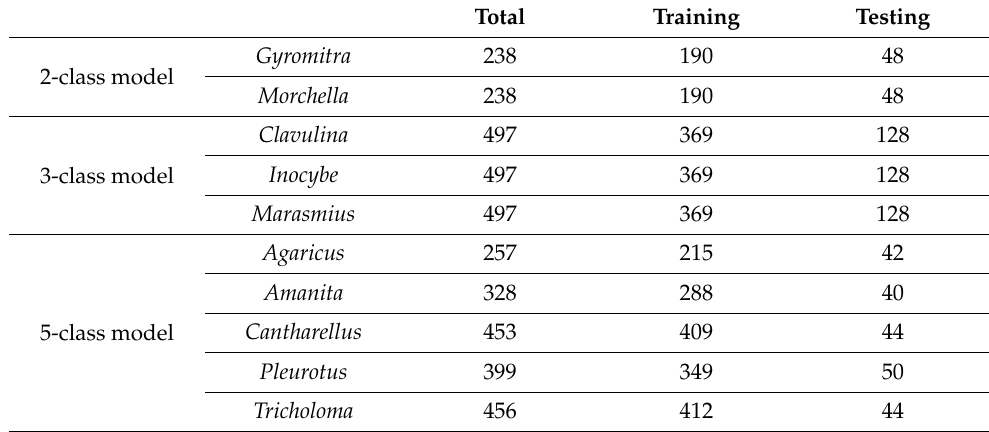
Table 1. Total number of images used for machine learning training and